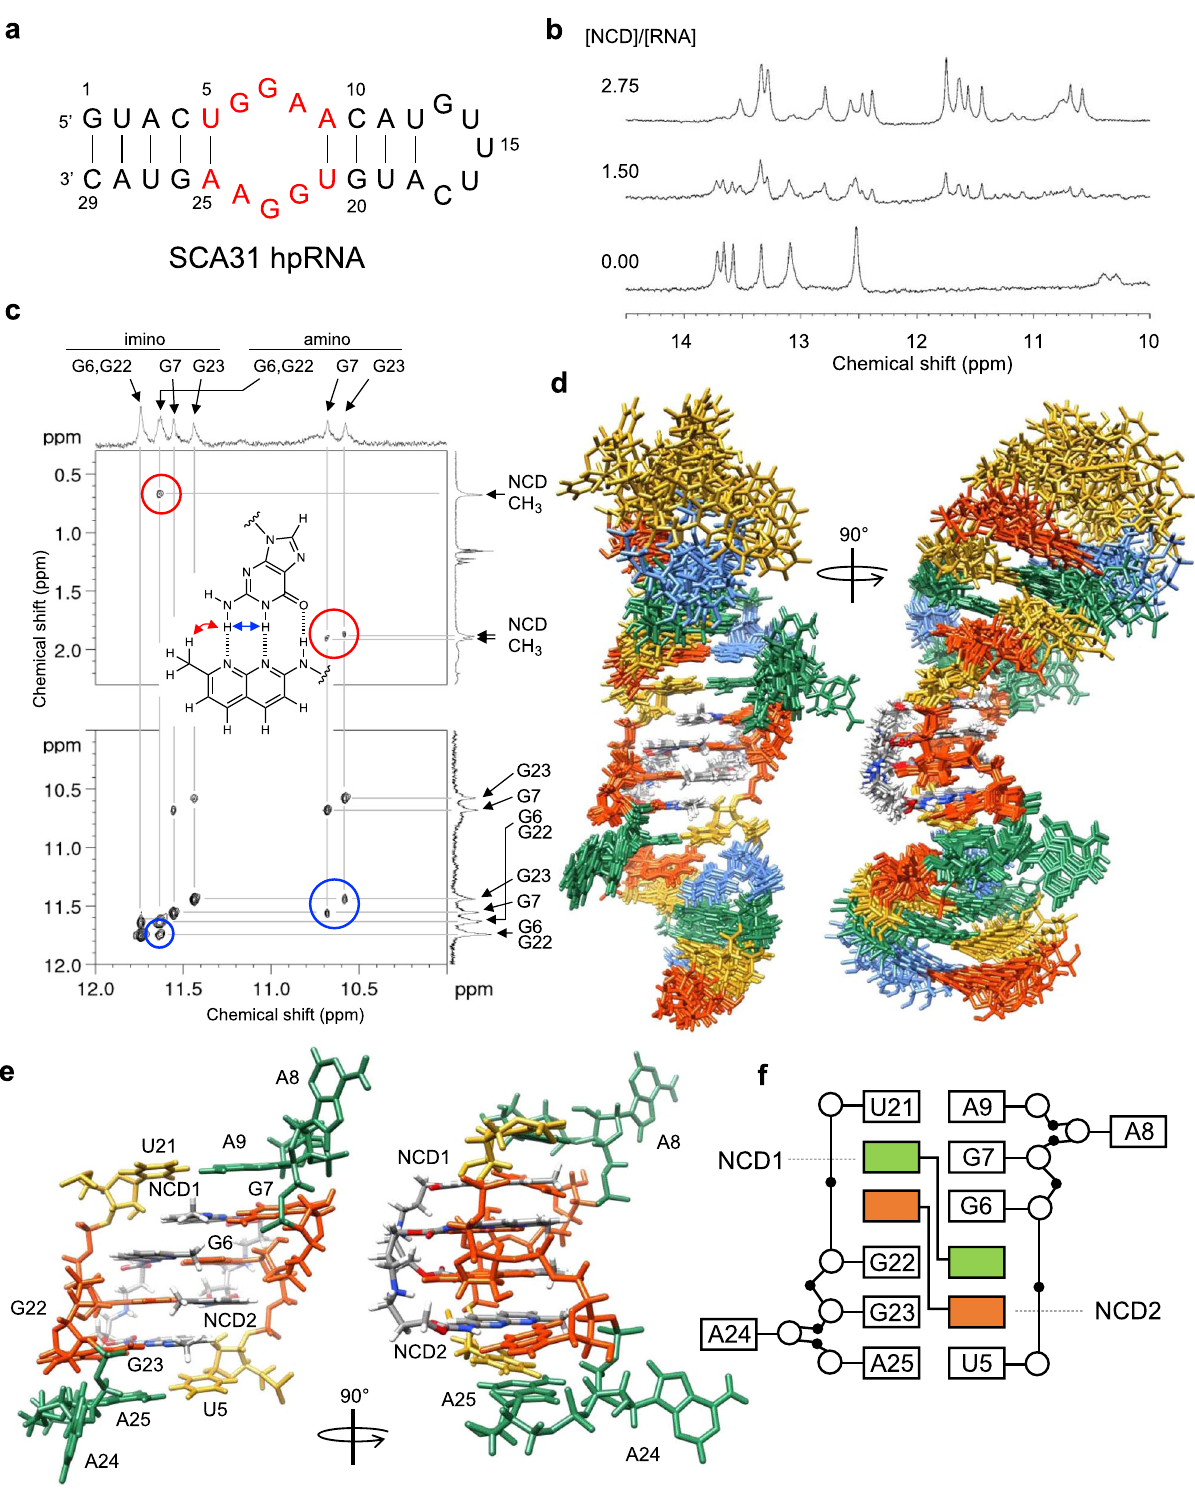
Fig. 3 NMR structural analysis of NCD-UGGAA/UGGAA pentad complex. a SCA31 hpRNA used for the NMR analysis. b Changes in imino proton spectra of SCA31 hpRNA upon addition of NCD. c NOESY spectra of NCD-SCA31 hpRNA complex. Correlations between amino hydrogen and methyl group (red circle) and amino and imino hydrogens (blue circle) were shown with the assignment of hydrogens. d Superposition of the ten lowest total energy structures of the NCD-SCA31 hpRNA complex. e Close-up structures and f structure pattern diagram of the UGGAA/UGGAA pentad bound with two NCD